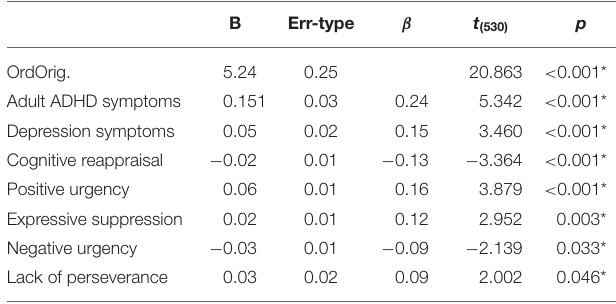
TABLE 3 | Multiple regression model explaining IAT score with stepwise